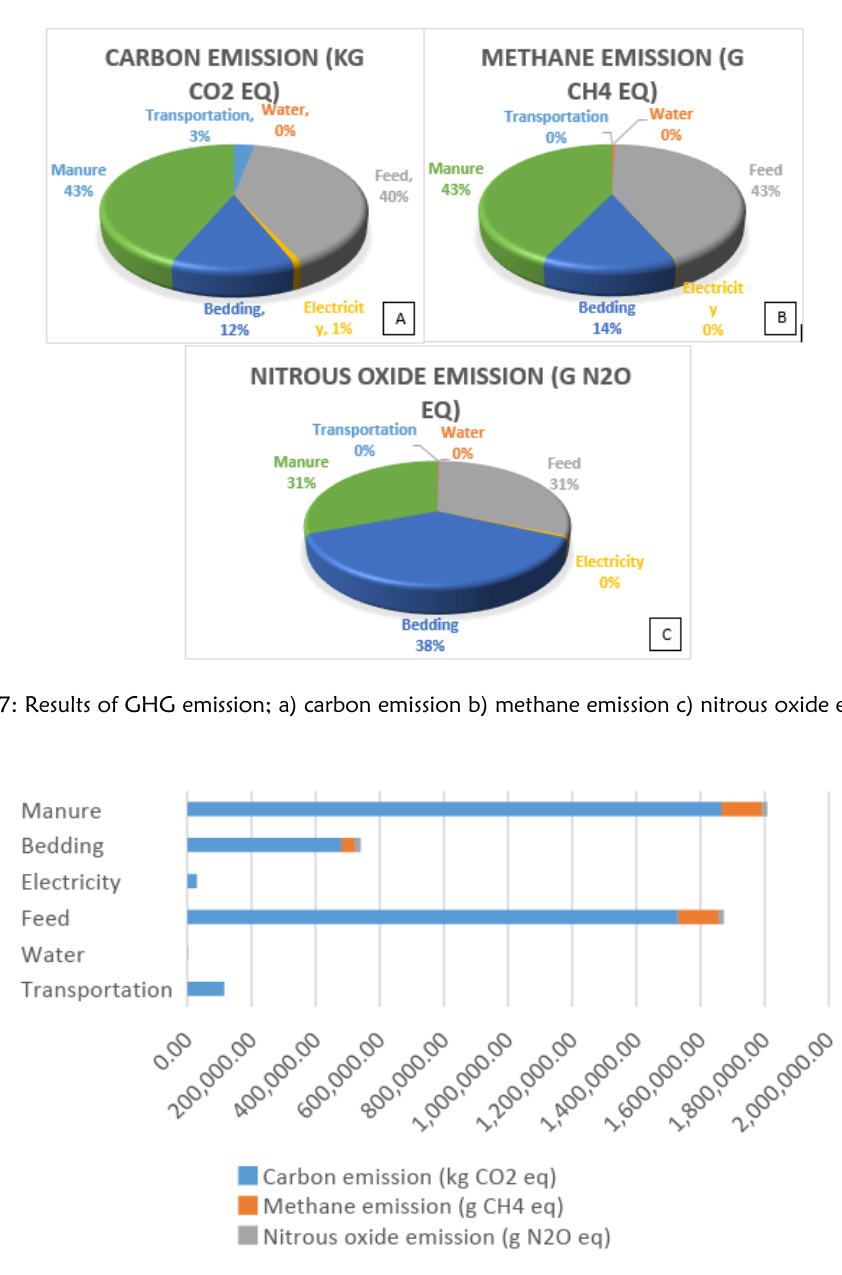
Figure 8: Greenhouse gas emission percentage according to activities in the broiler chicken